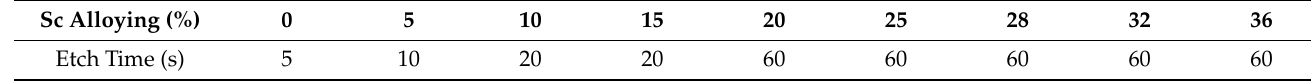
Table 4. Scandium concentration vs. etch time (short etch time in 30% KOH at 45 °C). Sc Alloying (%)